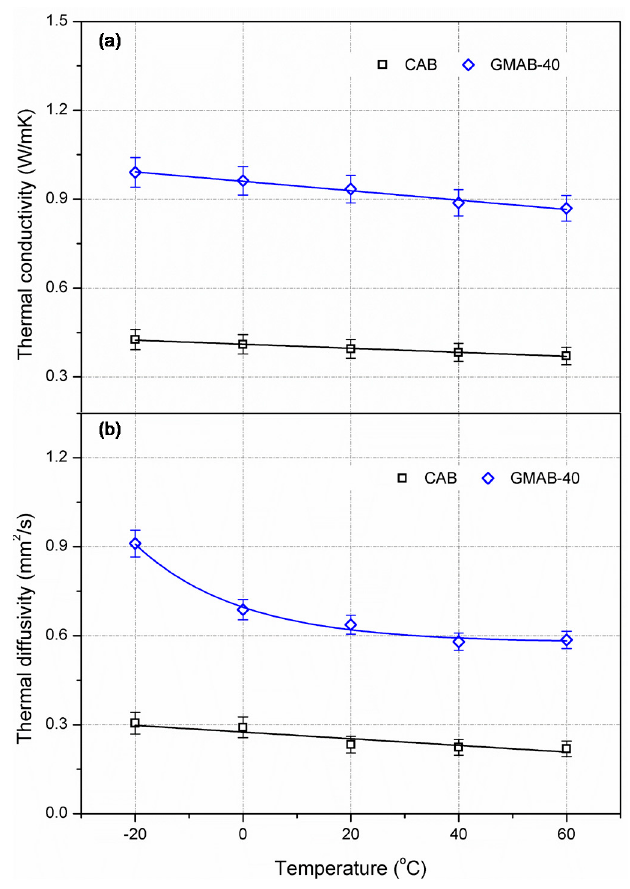
Figure 5. Effect of temperature on thermal characteristics of asphalt mortars. ( a ) Thermal conductivity; ( b ) Thermal diffusivity.